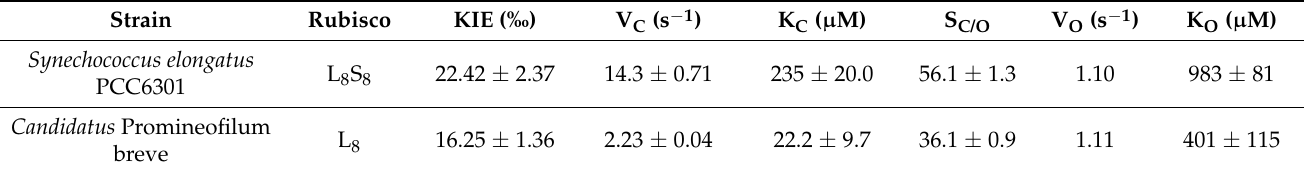
Table 1. KIE and non-isotopic kinetic measurements from L 8 vs. L 8 S 8